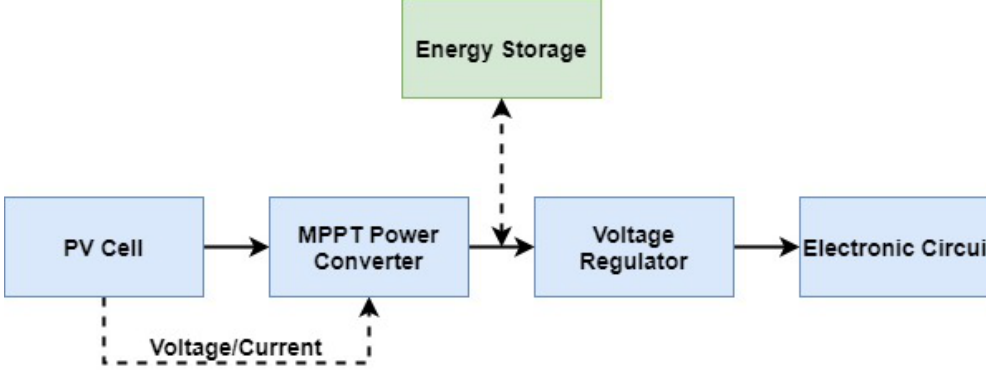
Figure 3. A conventional architecture of energy harvesting devices with the maximum power point tracking (MPPT) for storage.